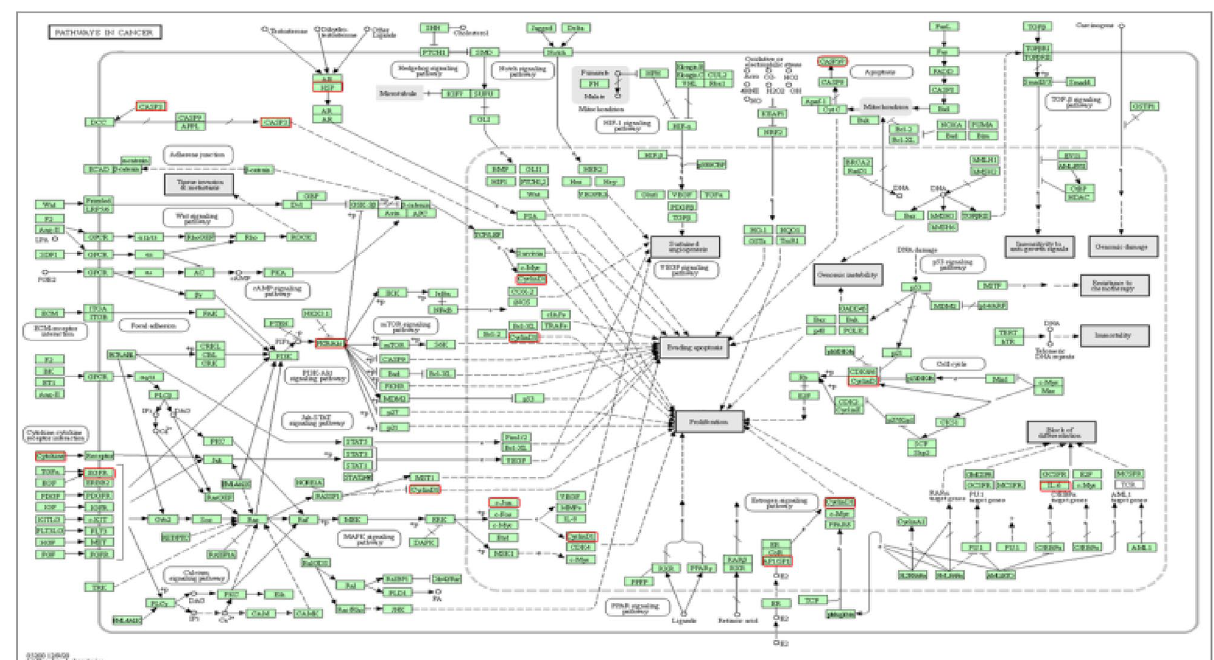
Figure 3. The possible role of hub gene in the regulation of HCC pathways (https:// www. genome. jp/